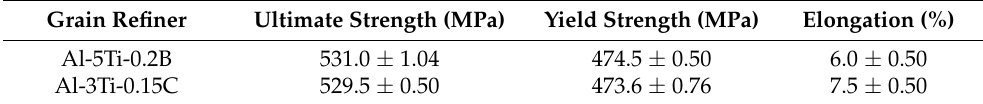
Table 2. Tensile Properties for 7050 Ingot after Treatment with Different Grain Refiners.